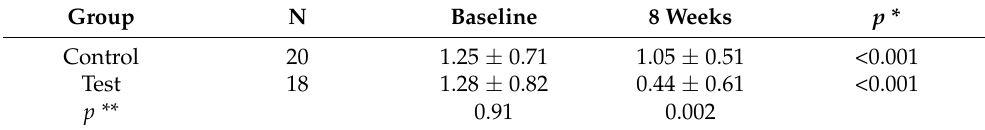
Table 3. Results of BANA test of CHX solution and CHX gel group. Mean ± SD. Group N Baseline 8 Weeks